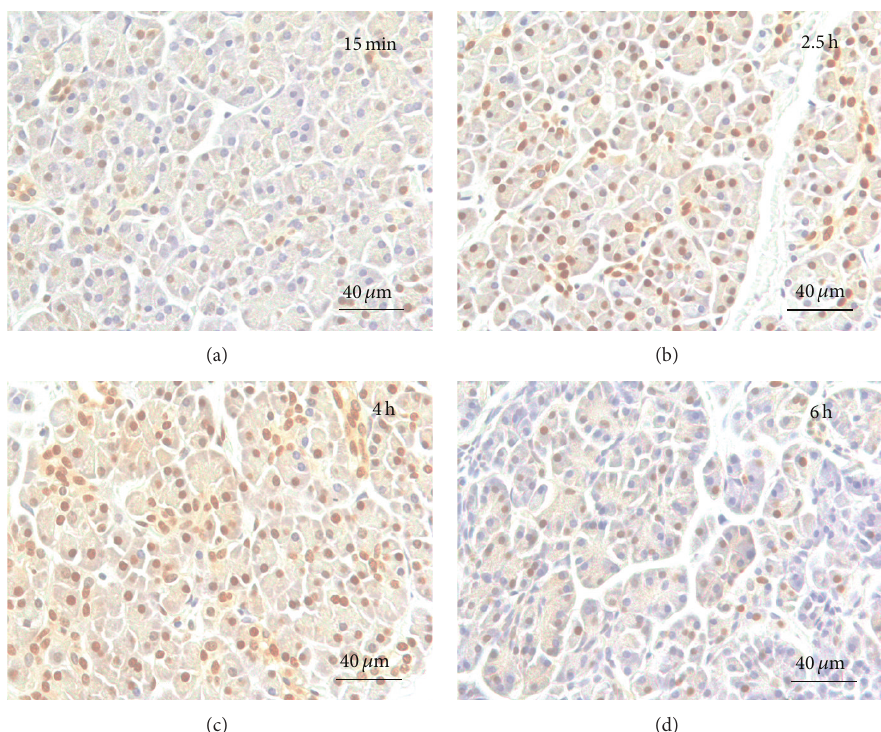
Figure 1: NF- 𝜅 B activation in acinar-cell-rich pancreas. Immediately after sampling, parallel portions of each tissue specimen were immersed in saline and kept at room temperature for 15 minutes (a), 2.5 hours (b), 4 hours (c), or 6 hours (d), after which they were fixed and processed for immunohistochemical analysis. The slides were counterstained with hematoxylin. Slight staining of acinar cell nuclei can be seen at 15 minutes (a) and significant amplification is observed at 2.5 hours (b). Almost every acinar cell nucleus is stained at 4 hours (c) and activation decreases at 6 hours